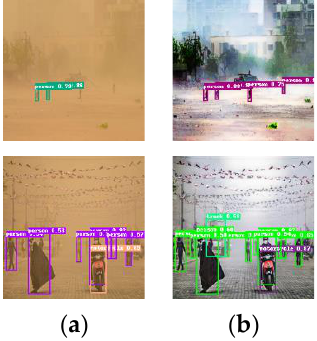
Figure 10. Effect on object detection; ( a ) The effect of object detection for sand-dust images; ( b ) The effect of detection after processing by the proposed algorithm.